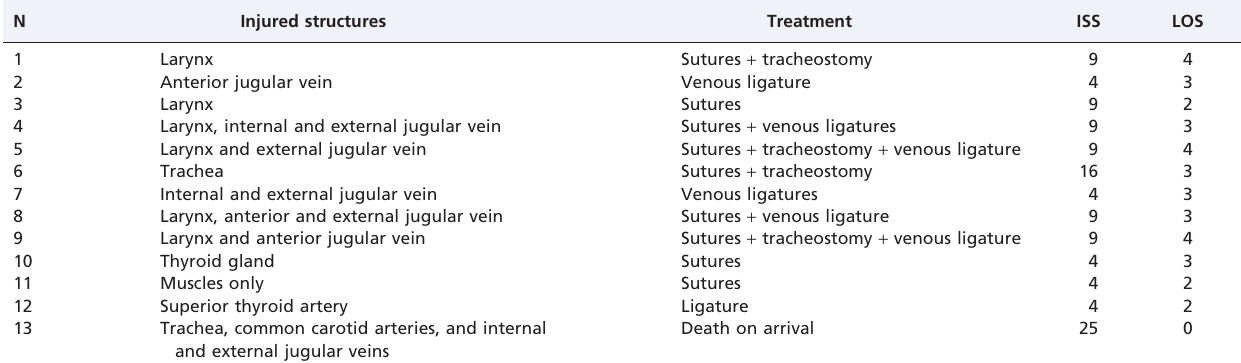
Table 1 - Injured structures, operative treatments, ISS, and